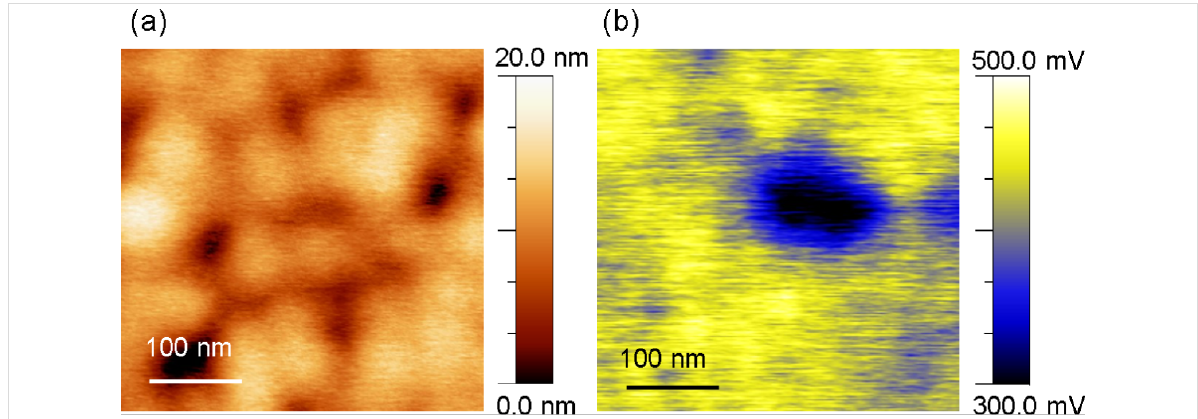
Figure 5: (a) 400 × 400 nm 2 AFM height image obtained in air on a TiO 2 /P3HT-COOH HHJ. KPFM height detection parameters: − 10 Hz of frequency shift setpoint and 5 nm of amplitude setpoint. (b) Corresponding KPFM V cpd image. KPFM V cpd detection parameters: frequency and amplitude of the electrical excitation: 80 Hz and 500 mV,